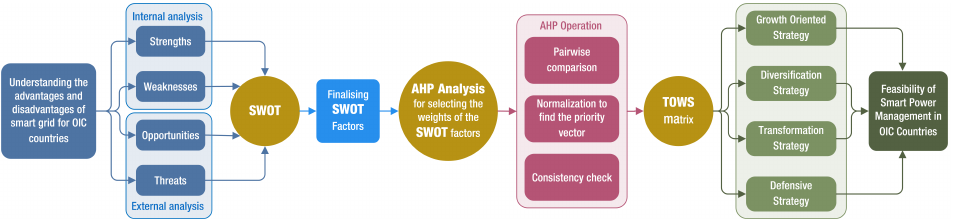
Figure 5. Process of the SWOT-AHP-TOWS analysis.